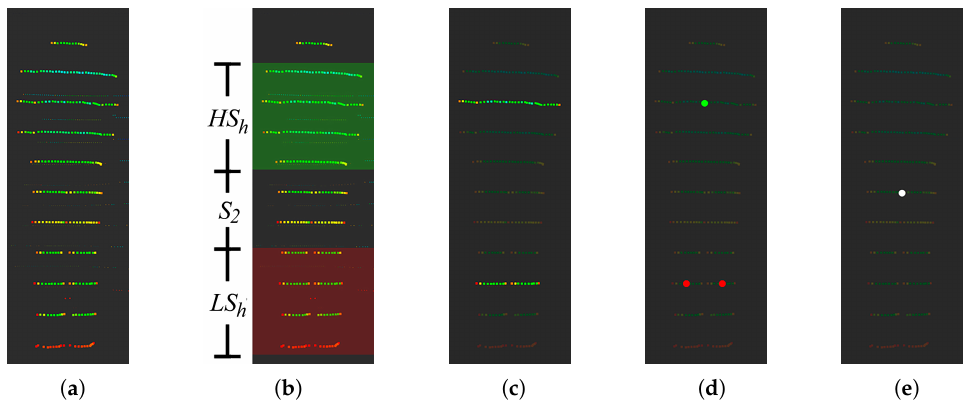
Figure 5. Height range segmentation for human detection: ( a ) sensed point-cloud; ( b ) definition of height ranges, points in green and red belong to two different HRC; ( c ) extraction of one layer per HRC; ( d ) extraction of cluster centroids for each layer; ( e ) matching between the points in the two sections to define the center of mass of the human